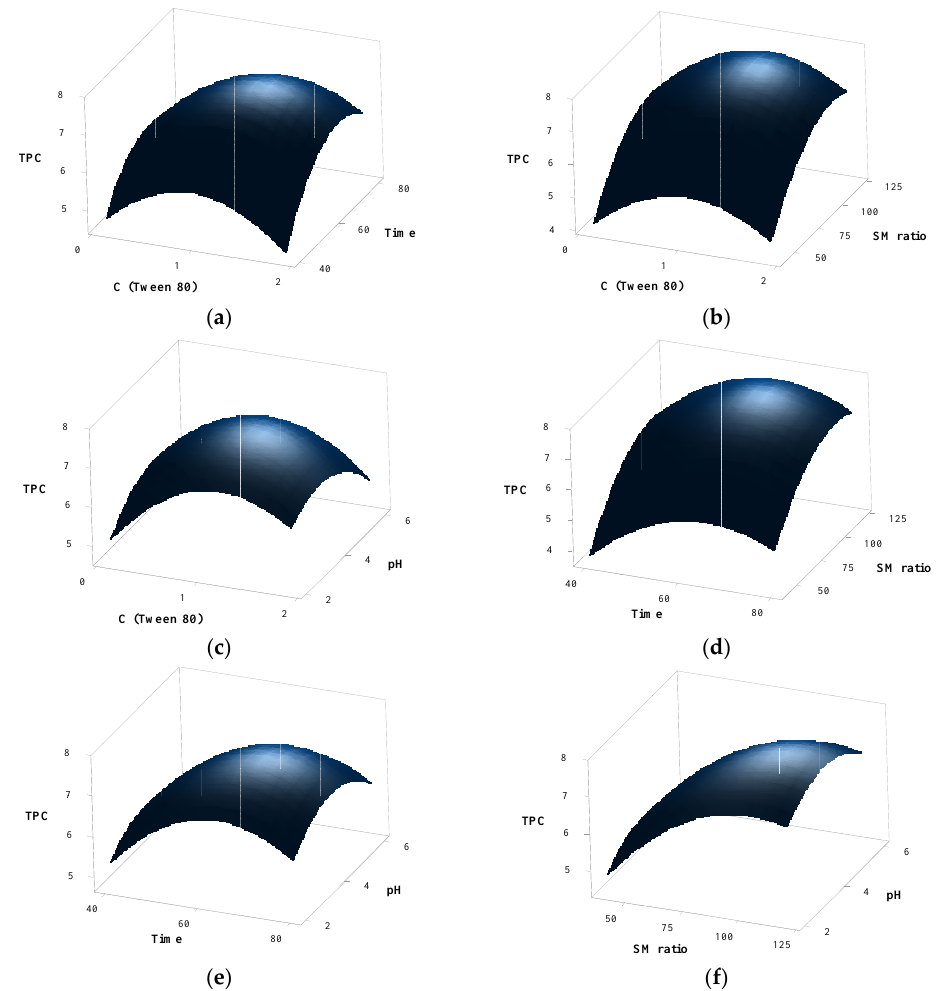
Figure 3. Response surface plots ( a – f ) showing effect of Tween 80 concentration, time, solid-to-material (SM) ratio, and pH on extraction of phenolic compounds from apple pomace.